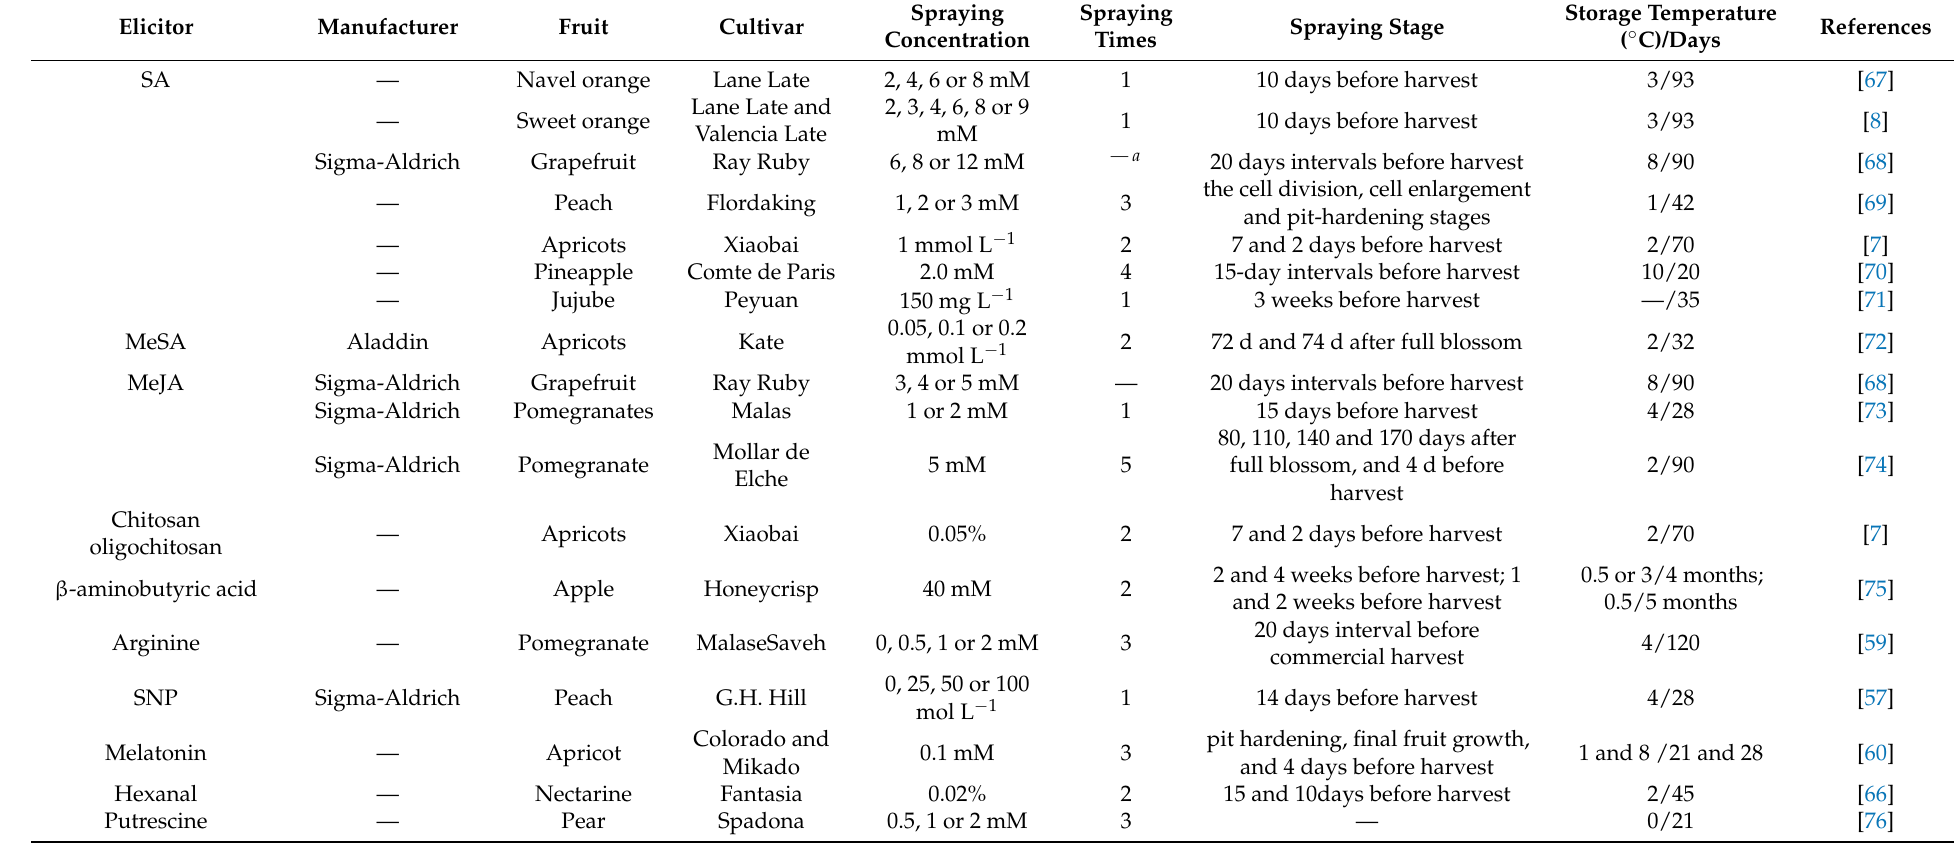
Table 2. Preharvest elicitors spray alleviates chilling injury in